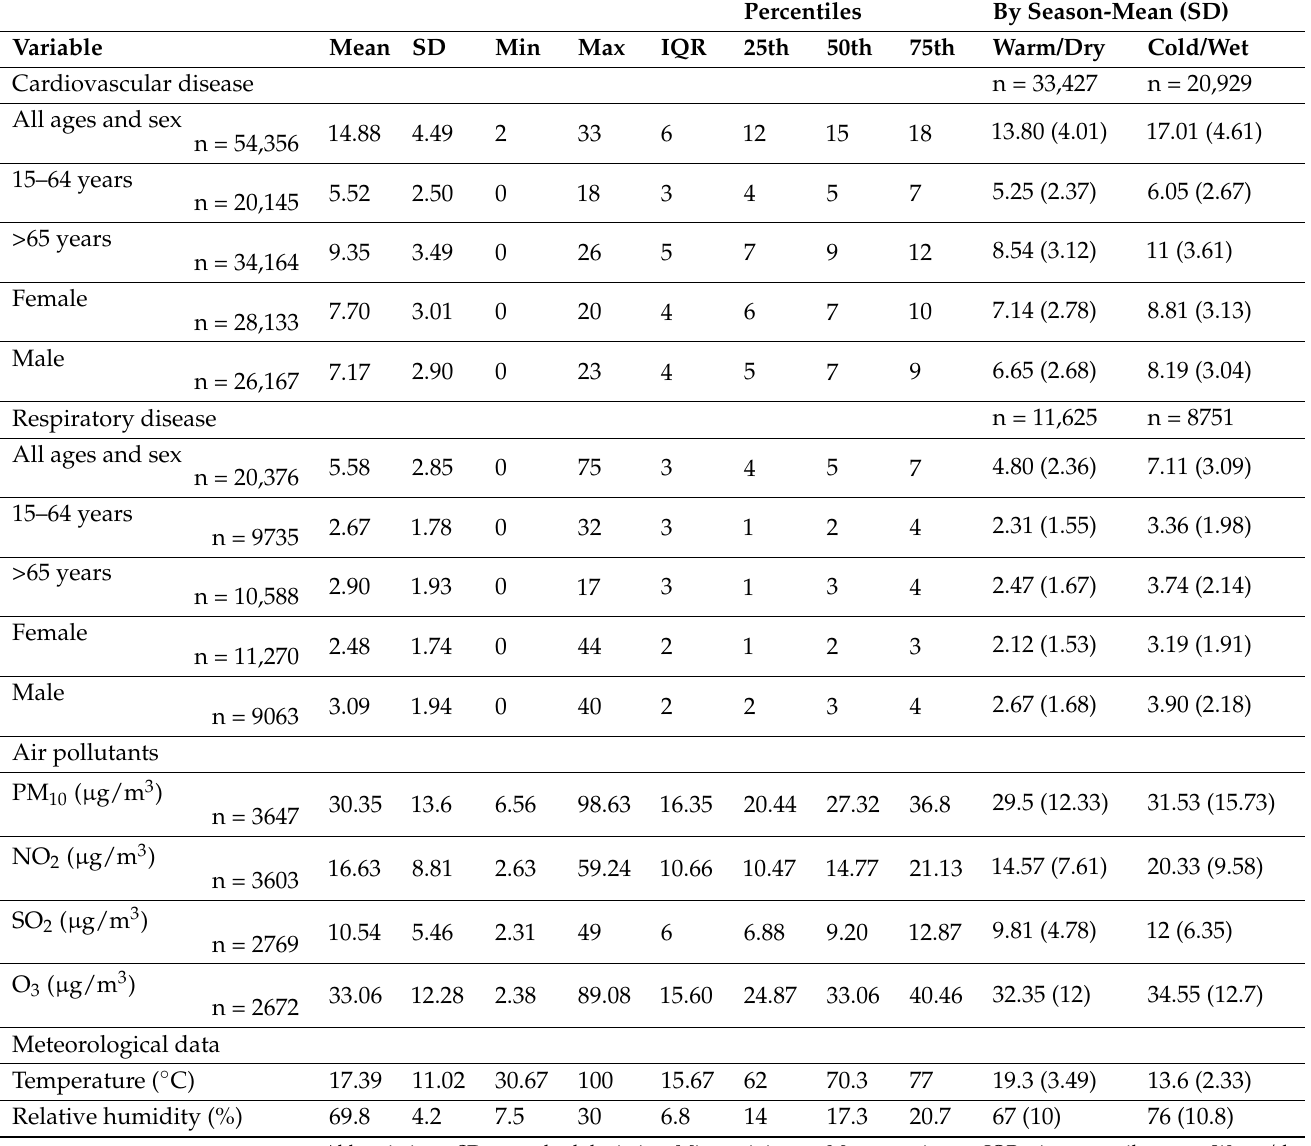
Table 1. Descriptive statistics for daily counts of cardiovascular and respiratory mortality, daily concentrations of PM 10 , NO 2 , SO 2 and O 3 and daily meteorological variables in Cape Town, South Africa during 1 January 2006 to 31 December 2015.